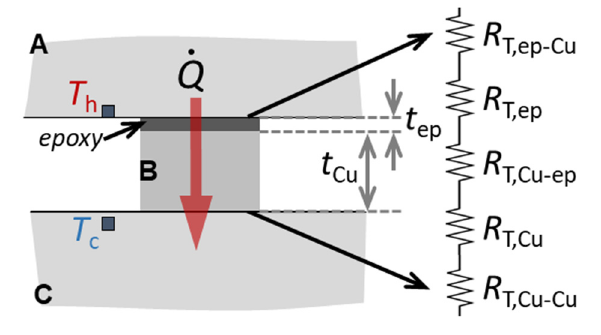
Figure 2. Scheme (cross-section view, not to scale) of the experiment to characterize the thermal resistivity of a Cu/epoxy/Cu joint. A, B, and C are made of copper (A and B are joined by 2850FT epoxy). The measured thermal resistance of the joint is the contribution of different thermal resistances, as explained in the text. The temperature difference across the joint ( T h − T c ) is measured by two thermometers. The contact area of the joint is A J = 2 cm 2 , t Cu = 6 mm and t ep ≈ 60–80 μ m.